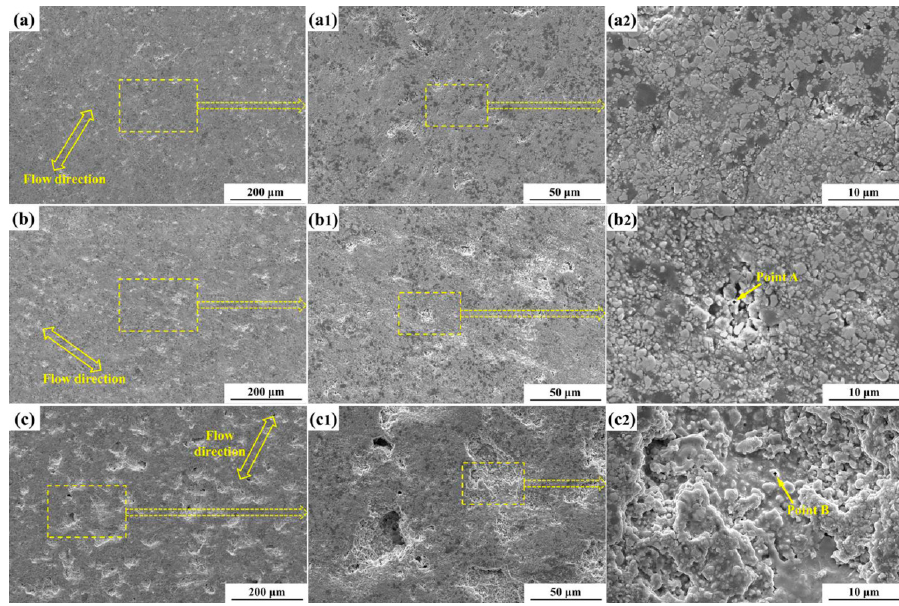
Figure 9. FE-SEM images of the WC-Cr 3 C 2 -Ni coatings after CSE for 6 h in 3.5 wt.% SCM at 20 kg·m − 3 and different FVs: ( a ) 23.4 m·s − 1 , ( b ) 33.5 m·s − 1 , ( c ) 41.9 m·s − 1 .